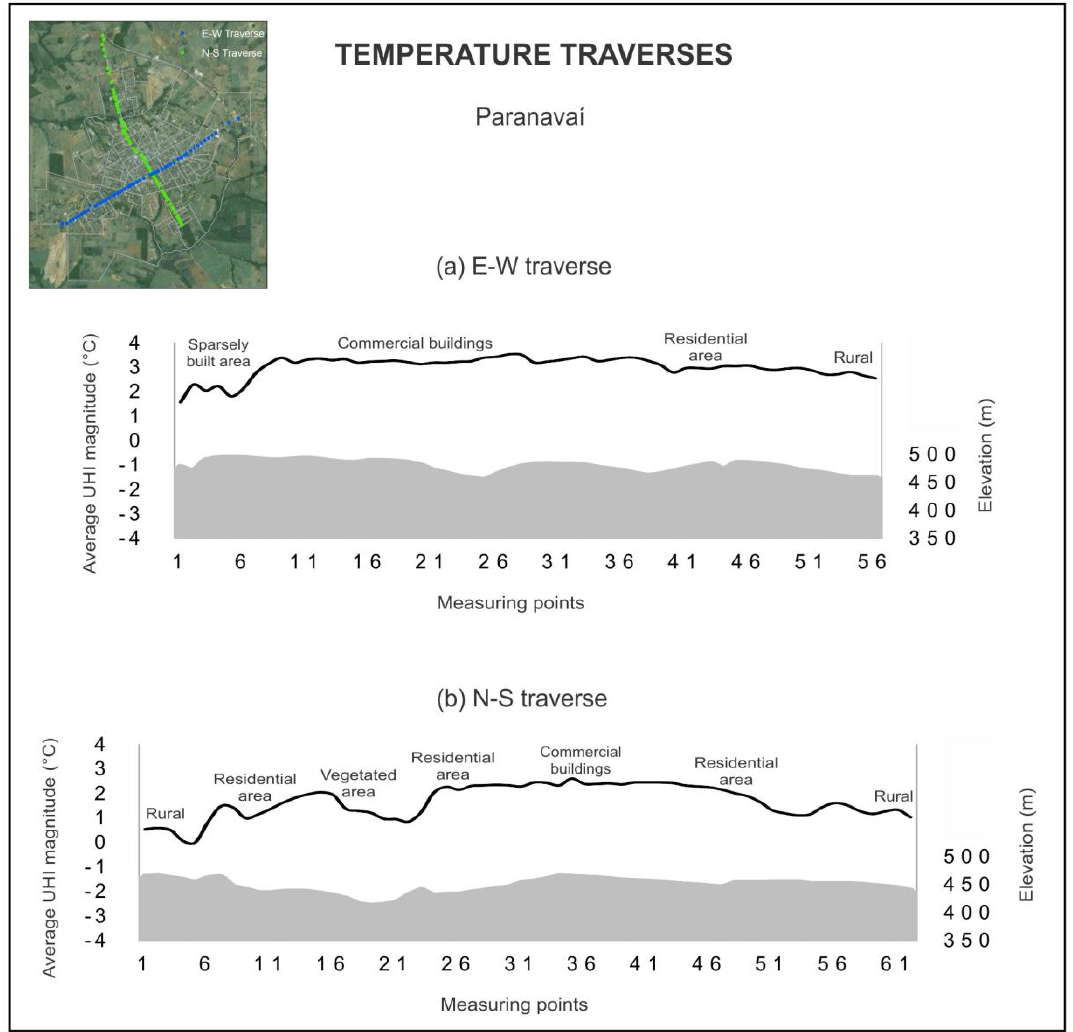
Figure 3. Summer average urban heat island (UHI) magnitudes in Paranavaí during nighttime traverses, January 2014 (5 = five nights): ( a ) east–west traverse; and ( b ) north–south traverse. Horizontal lines indicate the temperature profile. Surface relief is shown the along bottom axes.